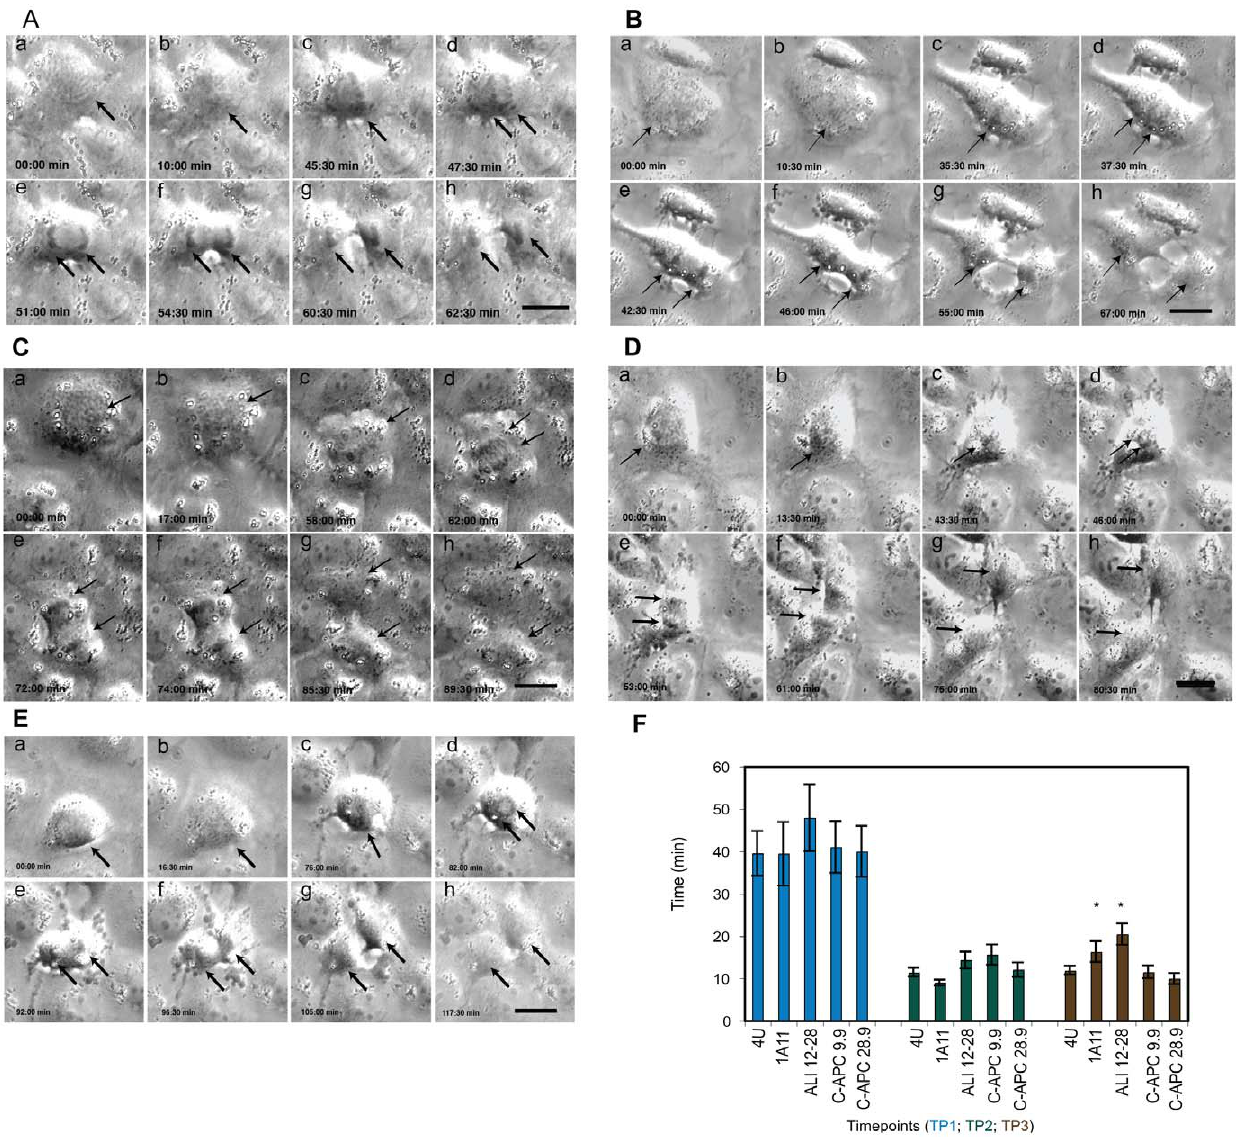
Figure 3. Mitotic progression in microinjected cells. Stills from representative time-lapse movies of mitotic NRK-52E cells microinjected with the five different monoclonal antibodies used in this study. A: cell microinjected with the non-specific control IgG 4 U. B: cell microinjected with the EB1 specific antibody 1A11. C: cell microinjected with the APC N-terminus specific antibody ALI 12–28, D: cell microinjected with the APC basic domain specific antibody C-APC 9.9. E: cell microinjected with the APC C-terminus specific antibody C-APC28.9. Scale bar=10 m M. a-gstills show different stages of mitosis, a- prophase, immediately after microinjection, b- prophase, c- metaphase, d- early anaphase, e- telophase, f–h- telophase/cytokinesis. The arrowsindicate theposition of the chromosomes. F. The time spentby injected cells in differentstages of mitosis is summarised in this graph. Time point 1 (TP1) represents the time taken from nuclear envelope breakdown to anaphase onset. TP2 represents the time taken from anaphase onset to the start of telophase. TP3 corresponds to the time taken from the start of telophase until the appearance of a phase-dense midbody during cytokinesis. No significant differences in the duration of these time points was seen in cells injected with the different antibodies until TP3, which cells injected with 1A11 (p , 0.05) and ALI 12–28 (p , 0.005) took significantly longer to transit. The graph shows the mean time in min + / 2 SEM for each condition. Significant results are indicated with an asterisk. (4 U, n=12; 1A11, n=9; ALI12–28, n=9; C-APC 9.9, n=14; C-APC 28.9, n=11).